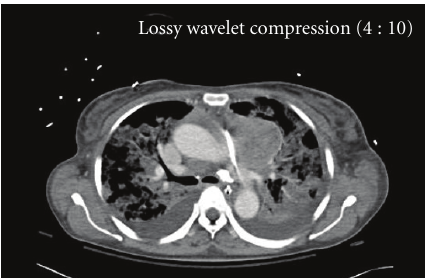
Figure 3: Computed axial tomogram showing a mass in left anterior mediastinum at the root of pulmonary artery with right anterior pericardial involvement and e ff